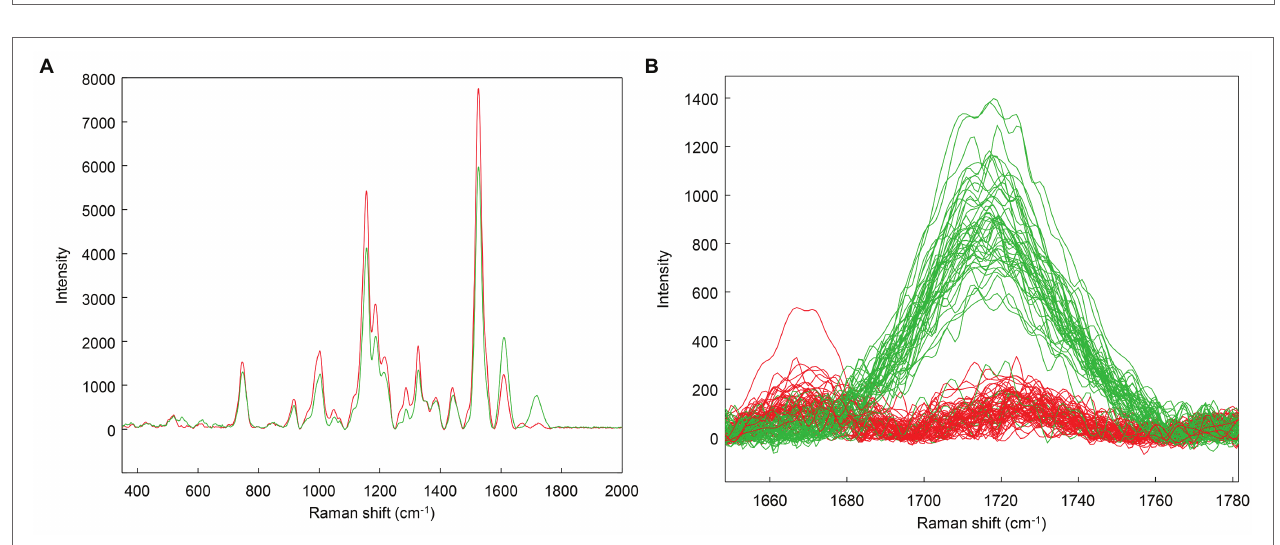
FIGURE 5 | Example cluster dendrograms and spectra for 2 (A,B) or 3 (C,D) clusters.